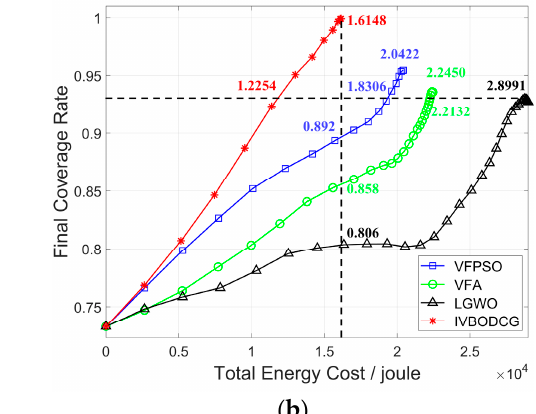
( d3 ) Figure 10. Coverage enhancement effects and movement trajectories of VFPSO, VFA, LGWO and IVBODCG after 28 rounds of movement. The circular areas with the solid points at the center are the